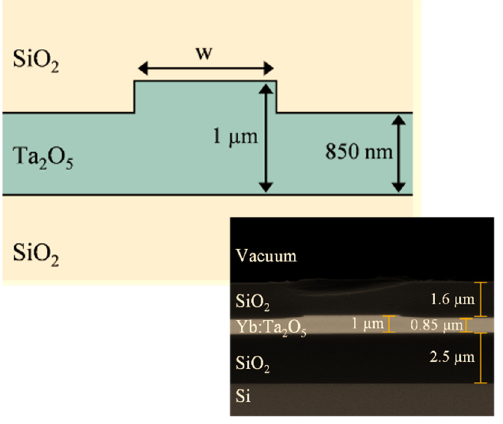
Figure 13. Cross section of the Ta 2 O 5 RIB waveguide; and ( inset ) SEM image of the fabricated final device covered by 1.6 μ m of SiO 2 (width = 5 μ m) [71].